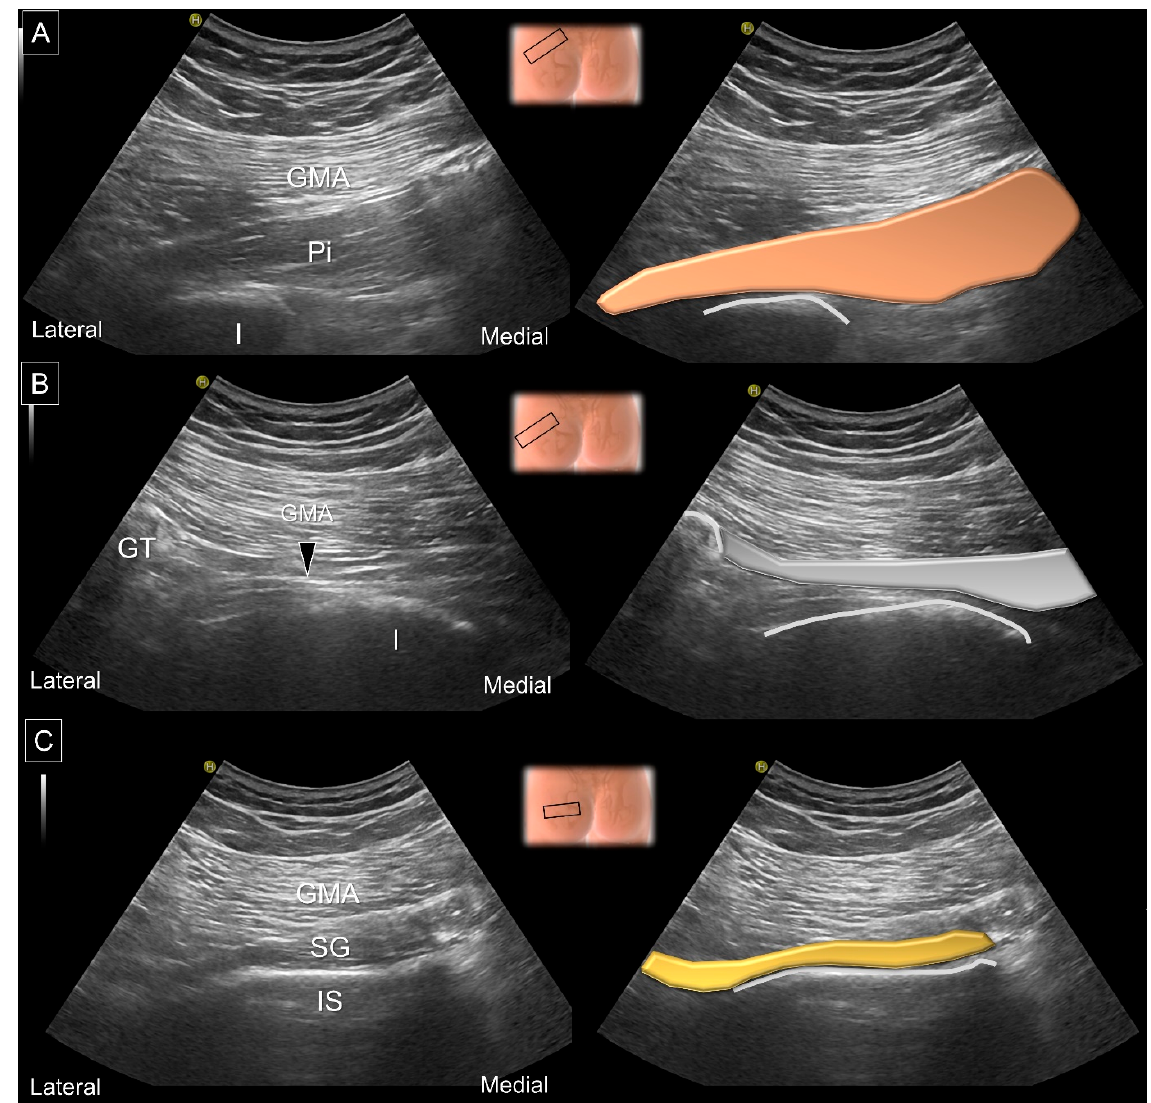
Figure 10. US images and schematic drawings of ( A ) the piriformis muscle and ( B ) its tendon (ar- rowhead, gray color) and ( C ) the superior gemellus muscle. GMA: gluteus maximus muscle; Pi: piriformis muscle, brown color; SG: superior gemellus muscle, yellow color; IS: ischial spine; I: is- chium; GT: greater trochanter. Black hollow square: transducer position.